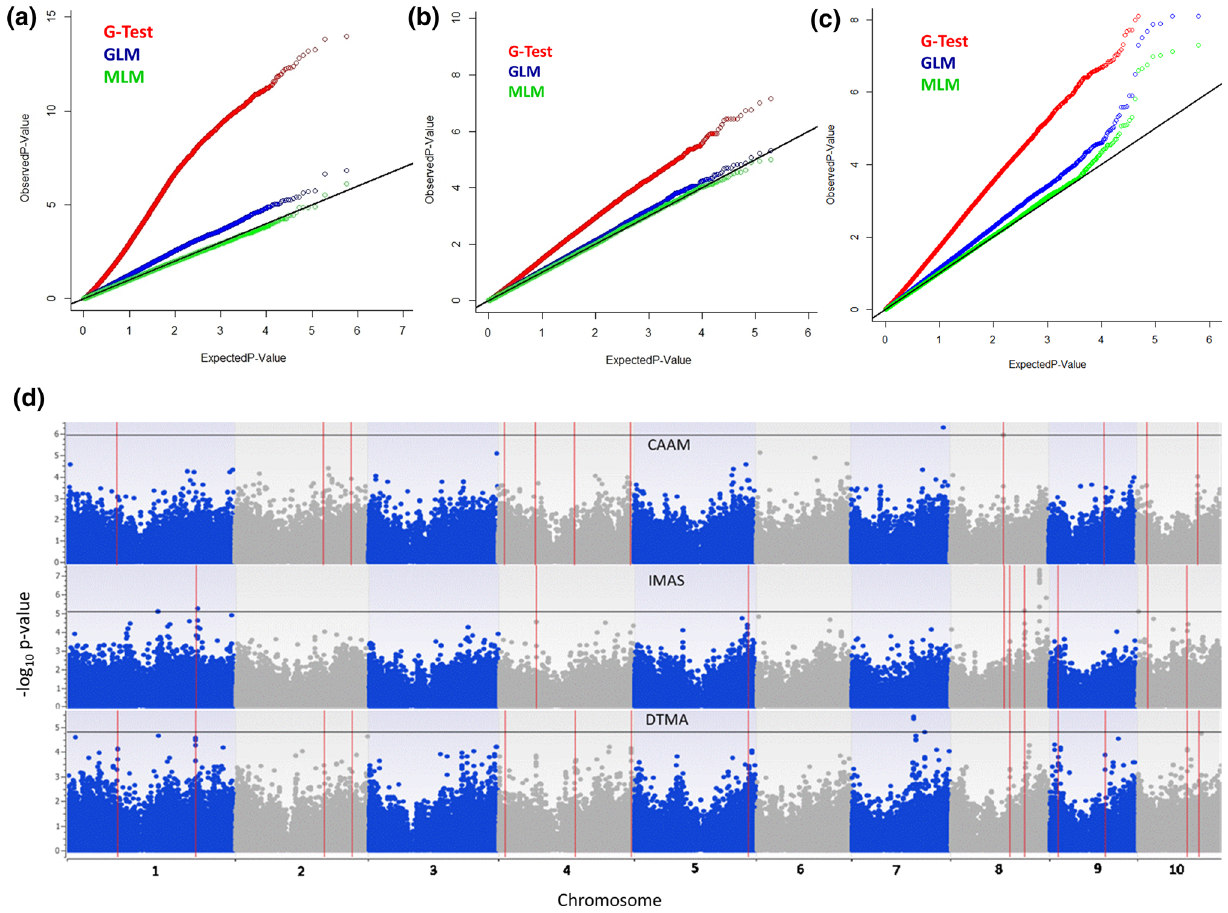
Figure 4. Inflation depicted by Q–Q plots of observed versus expected -log 10 ( P values) plots for NCLB using the naïve association model (G-test), GLM (G + Q) and MLM (G + Q + K); G = genotype (fixed), Q = ten principal components (fixed), K = kinship matrix (random) for ( a ) CAAM panel ( b ) DTMA panel and ( c ) IMAS panel; Highly significant SNPs identified from MLM model using Manhattan plot ( d ), plotted with the individual SNPs on the X-axis and − log 10 P value of each SNP on the Y-axis for the three panels, CAAM, IMAS and DTMA. The horizontal line shows the cut off P value and the vertical lines represent the common haplotypes identified in haplotype regression analysis across different panels for NCLB